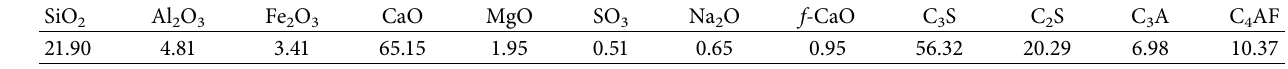
Table 1: Chemical and mineral components of cement clinkers (wt.%).